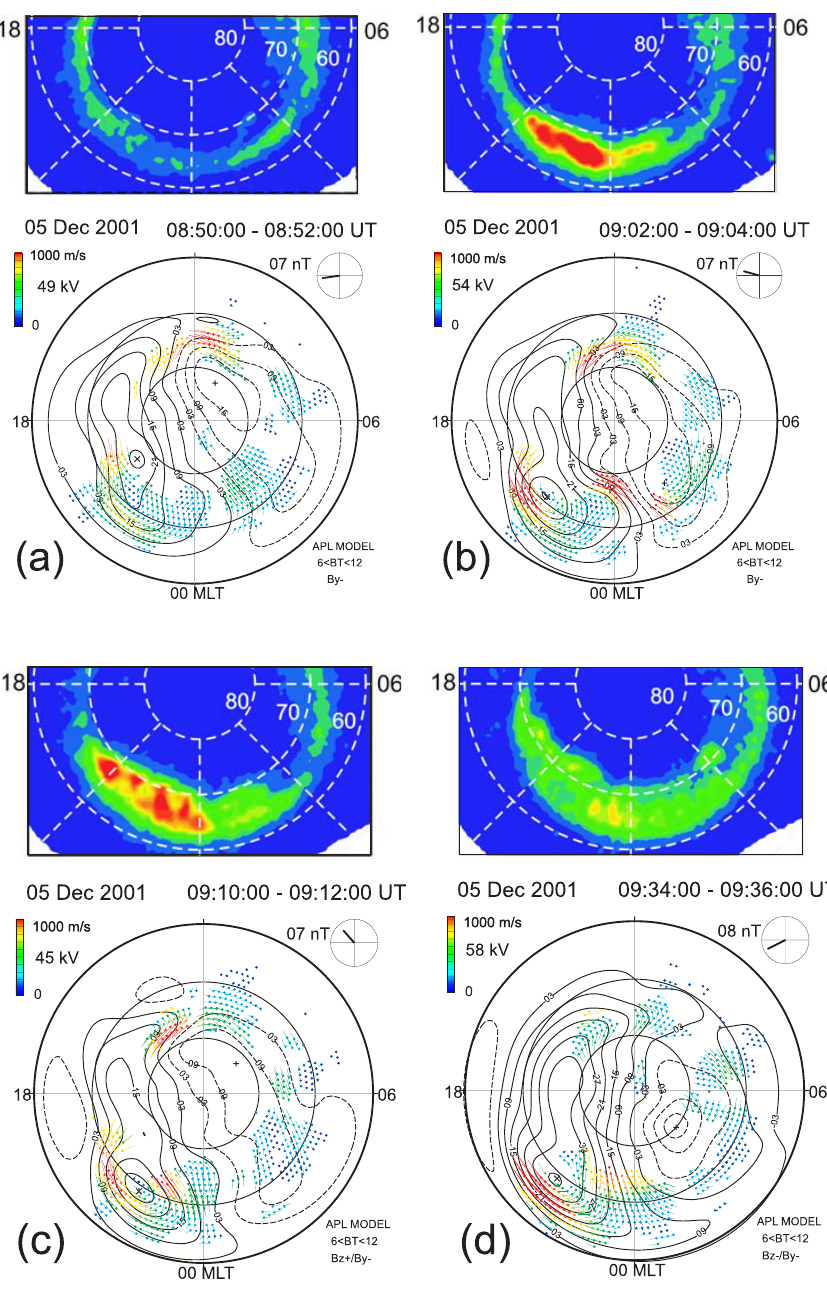
Fig. 6. Four global images of the auroral luminosity according to IMAGE observations and matched SuperDARN maps of plasma convection for a substorm on 5 December 2001. The onset occurred at ∼ 08:57 UT, according to IMAGE. Panel (a) corresponds to the growth phase of the substorm ( ∼ 7 min prior to the onset), panels (b) and (c) correspond to the active phase of the substorm ( ∼ 5min and ∼ 13min after the onset), and panel (d) corresponds to the substorm recovery phase ( ∼ 37min after the onset).